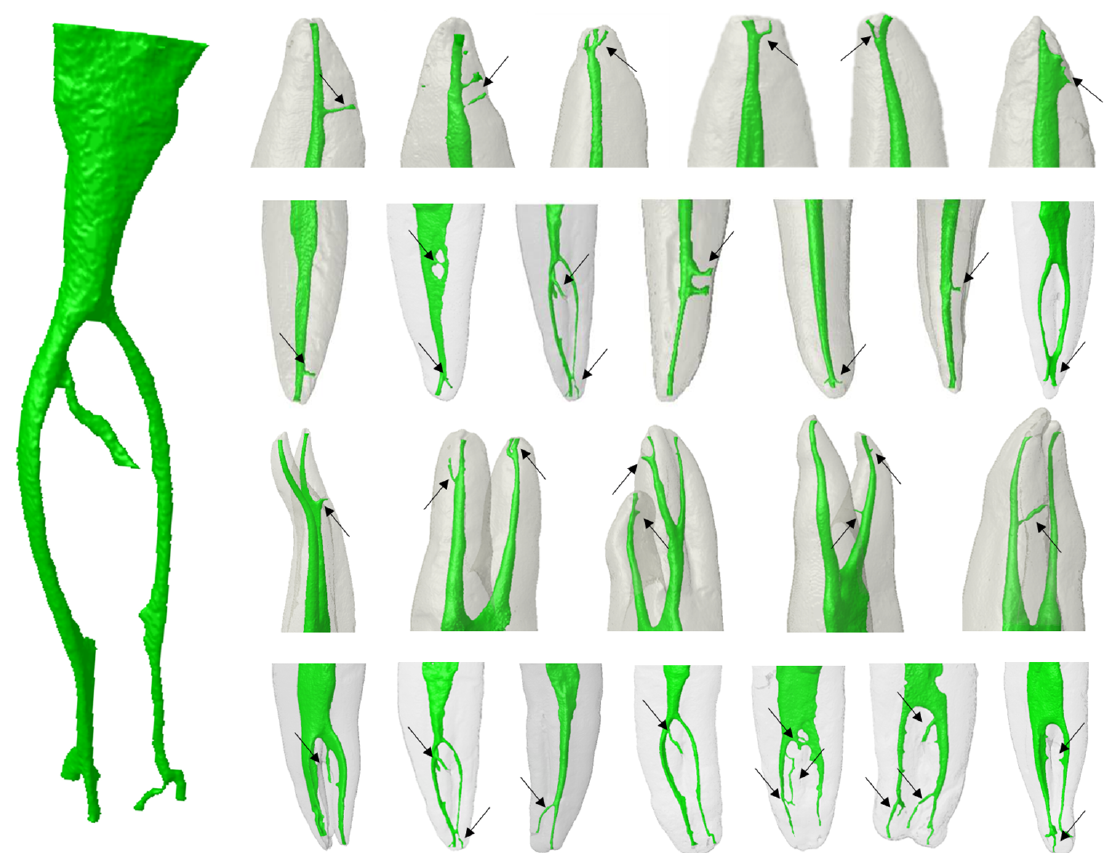
Figure 2- 3D models of maxillary and mandibular teeth showing the morphology of the root canal system according to the root thirds. The presence of main, accessories, lateral, secondary, collateral, intercanal, recurrent and reticular canals, and apical deltas was indicated by black